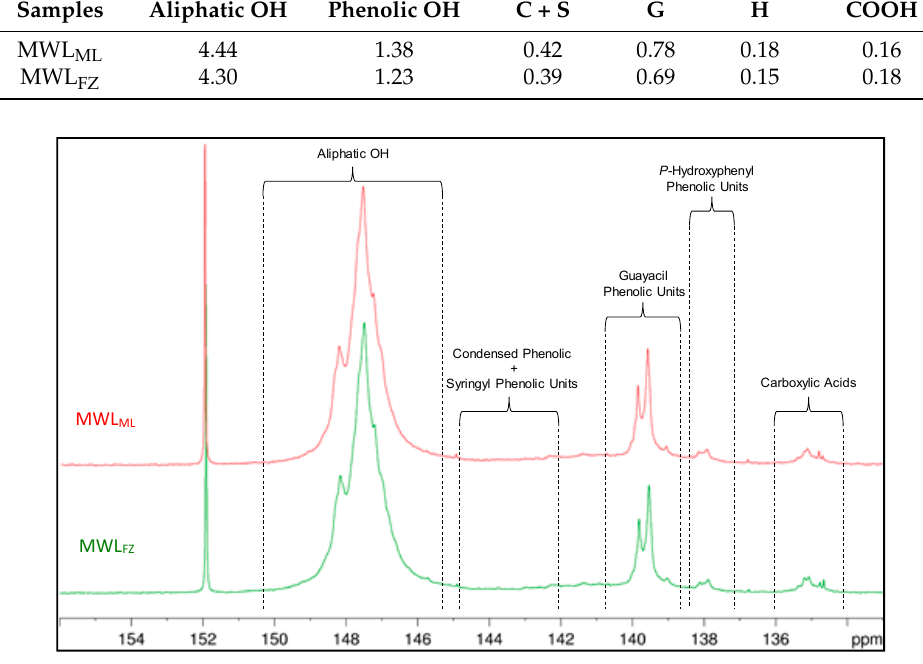
Figure 8. 31 P NMR spectra of MWL ML and MWL FZ .